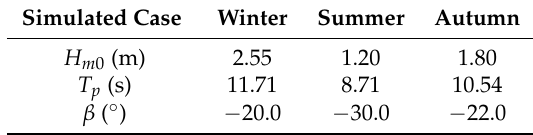
Table 3. WEC farm modelled scenarios for irregular